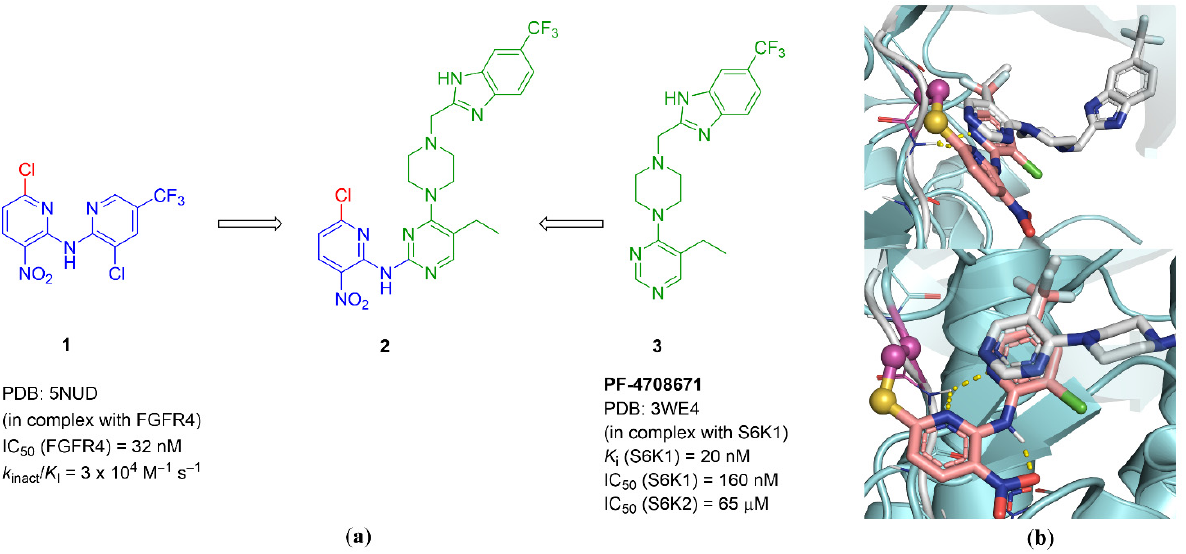
Figure 1. ( a ) Merging of PF-4708671 ( 3 , green) [31] with compound 1 (blue) [27] containing a reactive chloronitropyridine (leaving group in red); ( b ) crystal structure overlay of FGFR4 in complex with compound 1 (salmon; FGFR4 backbone in cyan) and S6K1 in complex with PF-4708671 (grey). The dotted yellow lines indicate the supposed chelate-type hydrogen bond formed by compound 1 , as well as the intramolecular hydrogen bond between the nitro group and the diaryl- NH . The FGFR4 cysteine (Cys 552 ) is highlighted in magenta.